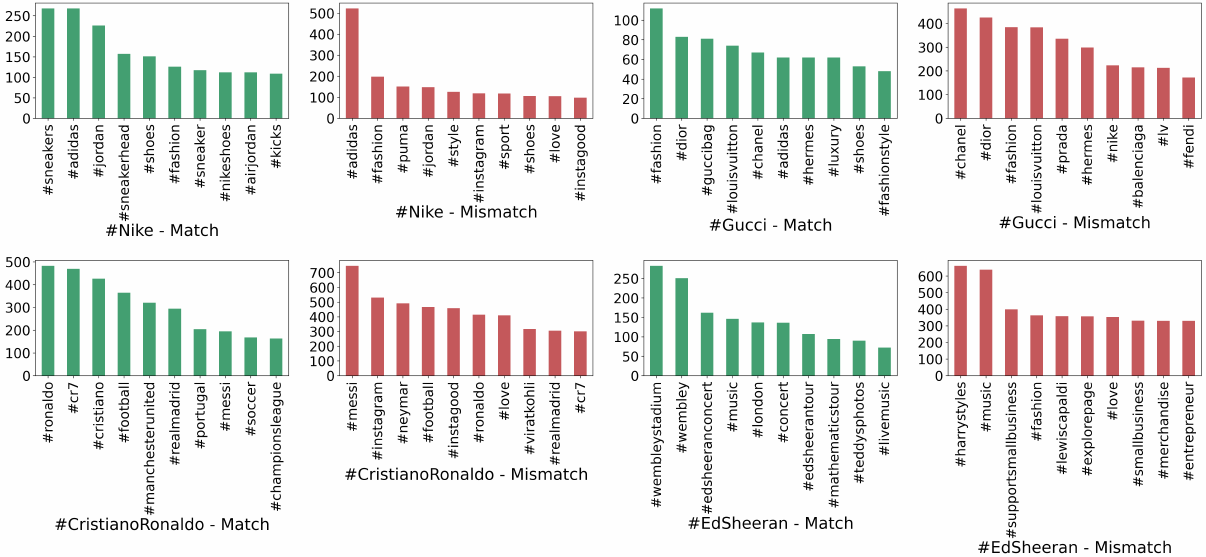
Figure 7. Frequency of the top 10 hashtags about the match and mismatch content in each category on